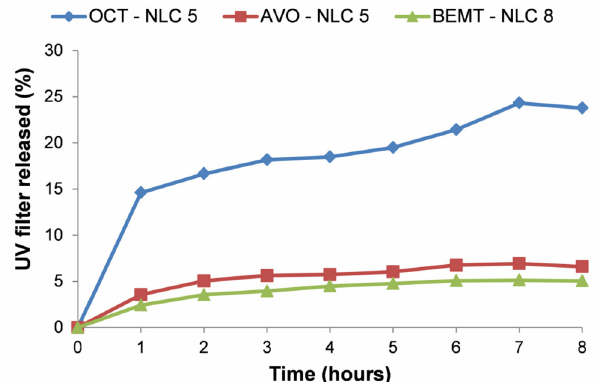
Figure 11. The release profiles of OCT, AVO and BEMT from the developed lipid nanocarriers.